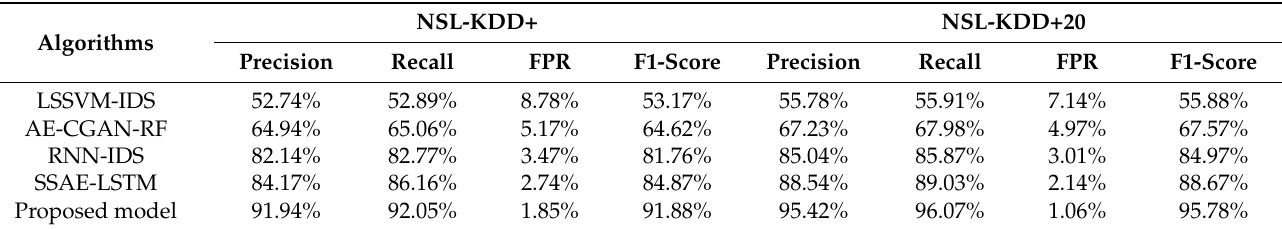
Table 2. Overall performance